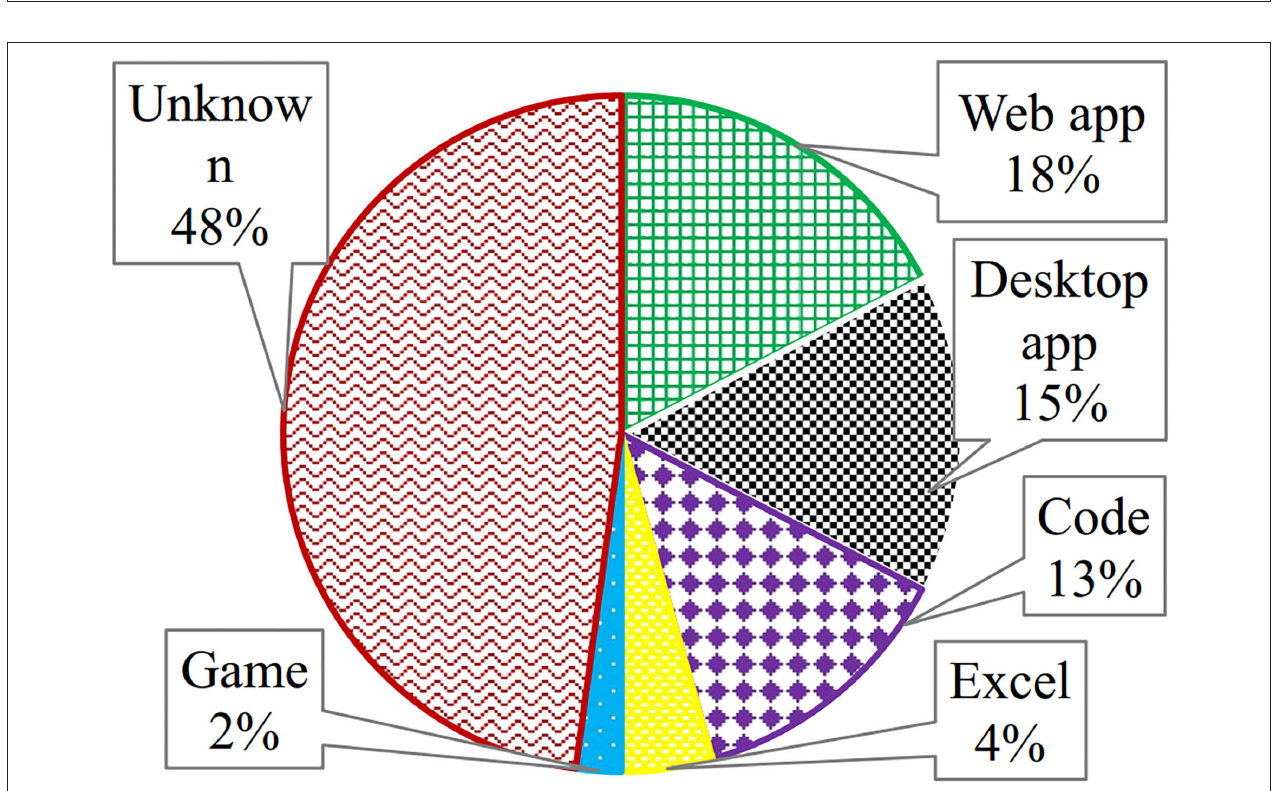
FIGURE 6 | Format of WEF nexus